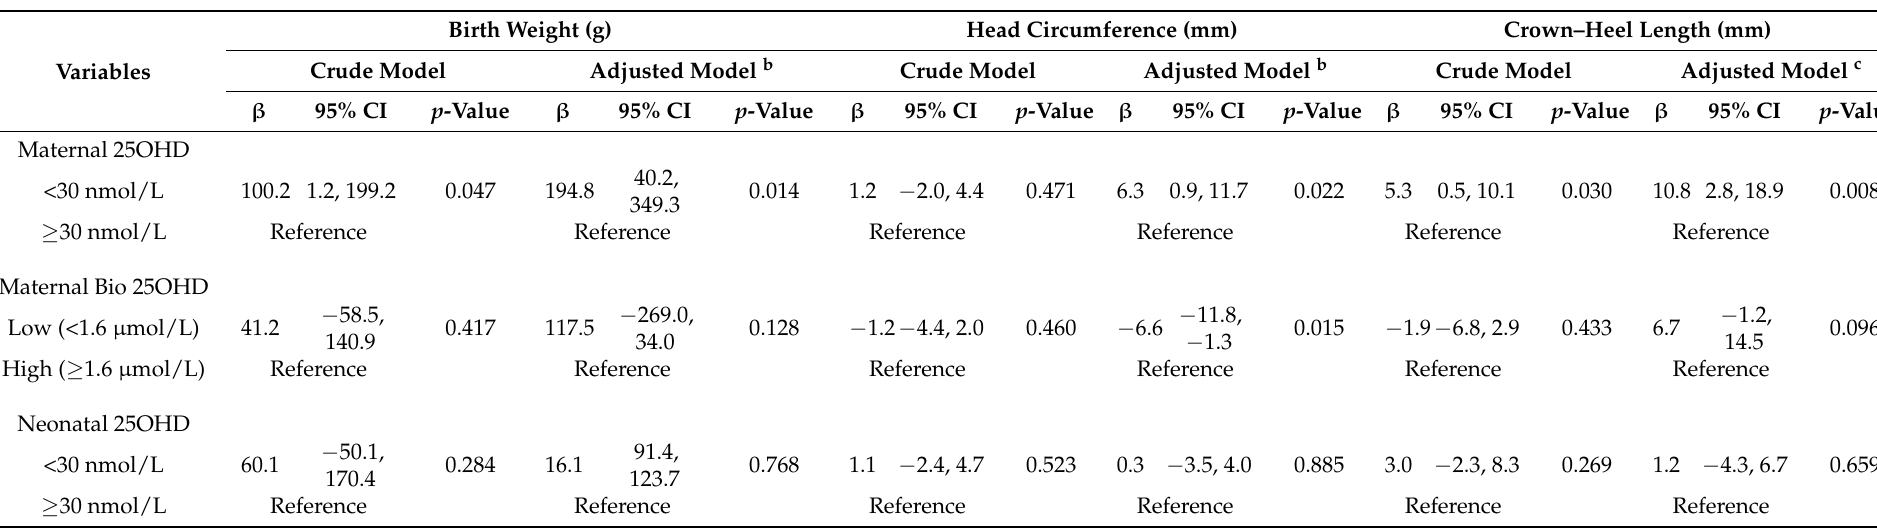
Table 3. Associations of maternal and neonatal vitamin D deficiency and maternal bioavailable 25OHD with birth outcomes a